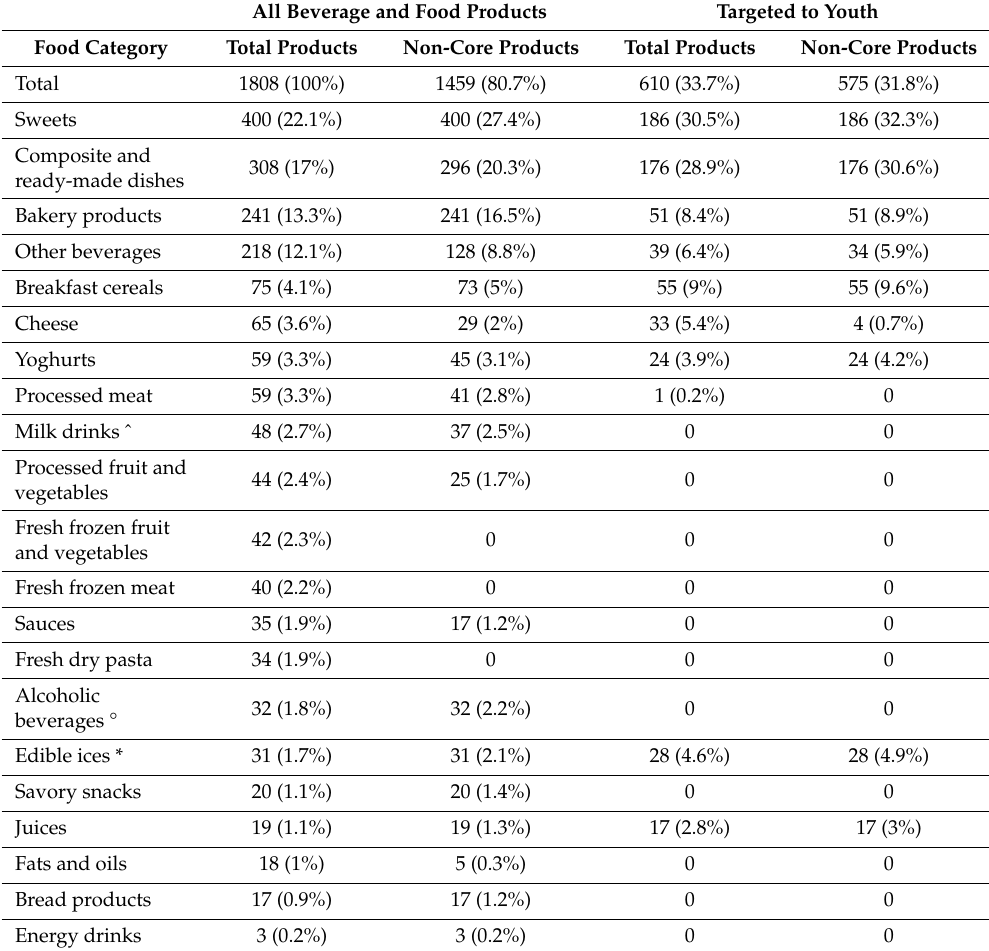
Table 1. Prevalence of food and beverage